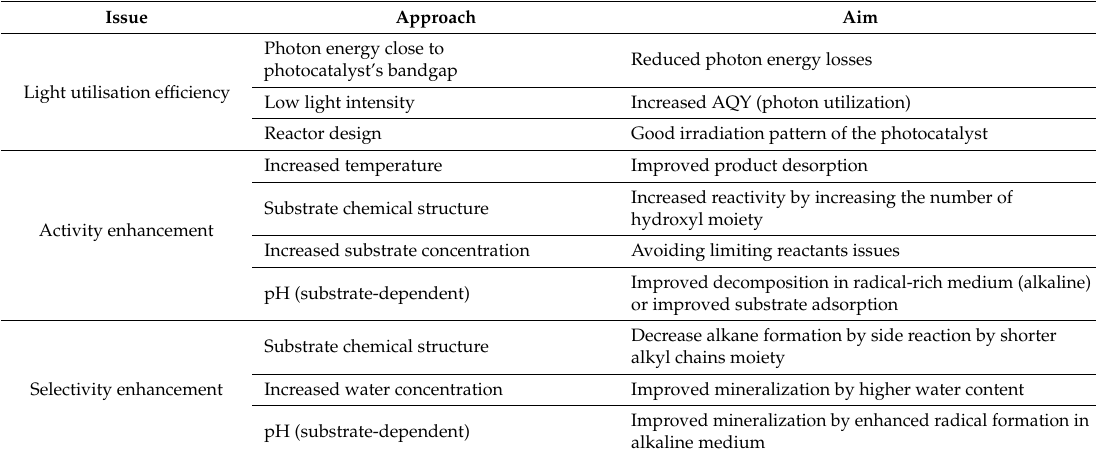
Table 5. Summary of features to consider on PR reaction